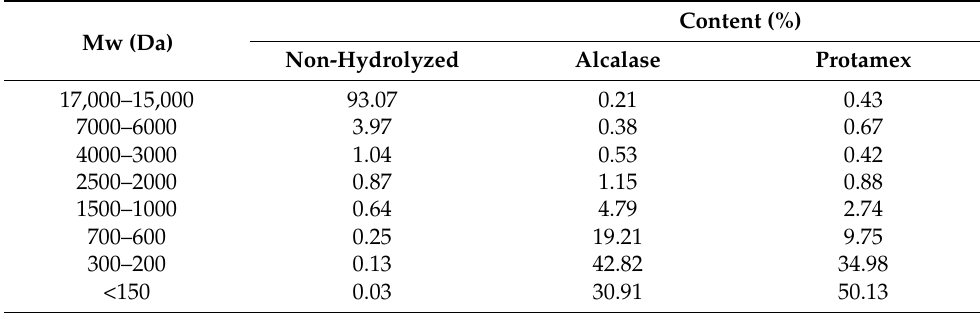
Table 2. Molecular mass distribution of non-hydrolyzed soybean protein and Alcalase, and Protamex hydrolysates. The spectra were obtained via HPLC (dry weight